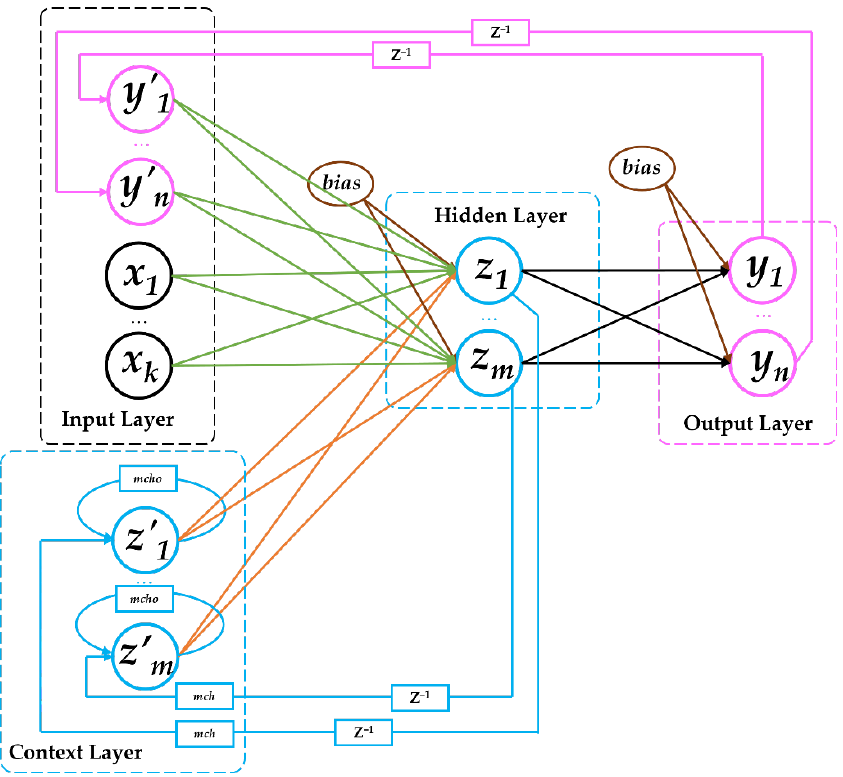
Figure 4. Scheme of the proposed modified ENN.